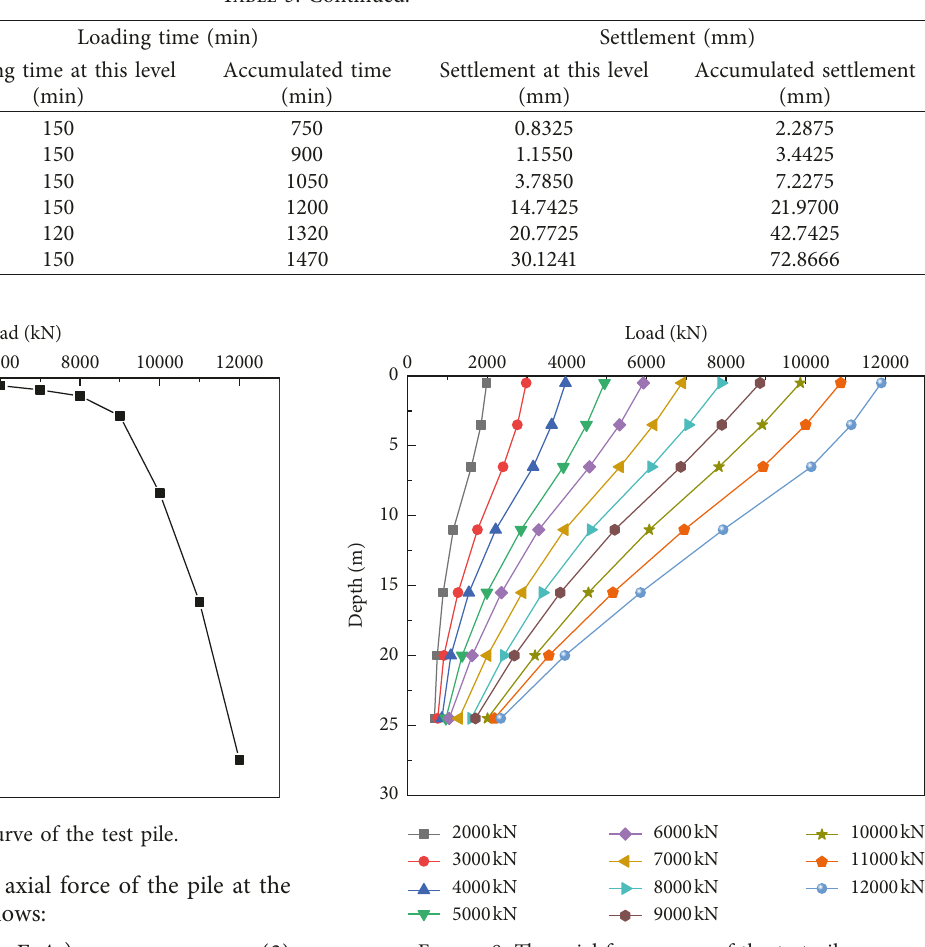
Figure 8: The axial force curve of the test